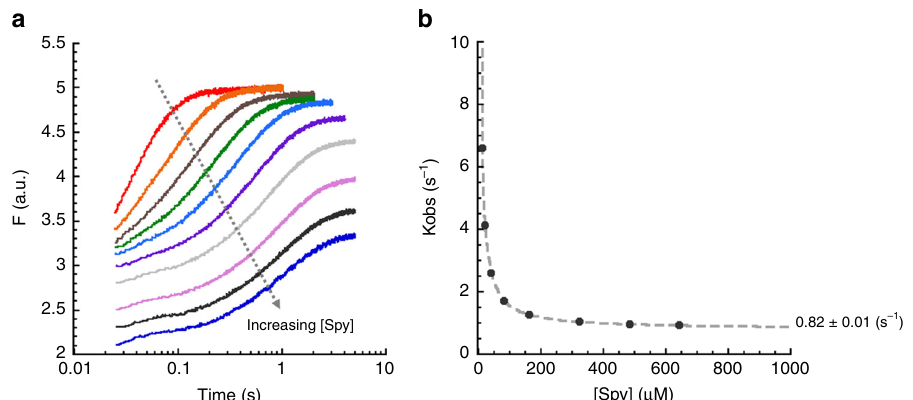
Fig. 1 Kinetic analysis of SH3 refolding in the presence of Spy. a The graph shows the fl uorescence traces of SH3 refolding in the presence of various concentrations of Spy (0 – 643 μ M dimer after mixing). All traces could be fi t with a single exponential function. The decrease in the fl uorescence intensity at high Spy concentrations is due to the inner fi lter effect caused by tyrosines in Spy. b Plot of k obs for SH3 folding as a function of Spy concentration. The − 1 at saturation k obs hyperbolically decreased as the Spy concentration increased, reaching 0.82 ± 0.01 s